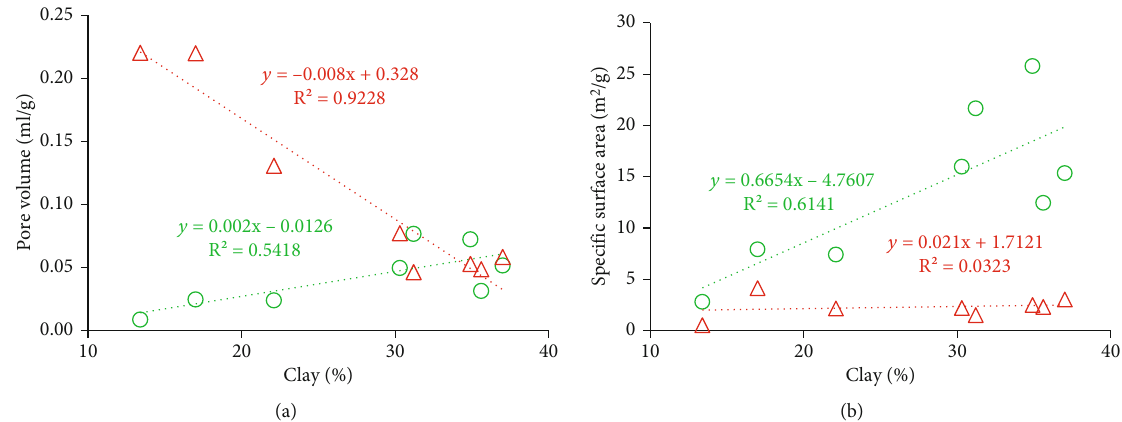
Figure 14: Plots showing the relationship between pore structure and clay mineral content. (a) Macropore volume has a negative correlation with clay; (b) mesoporous speci fi c surface area is positively correlated with